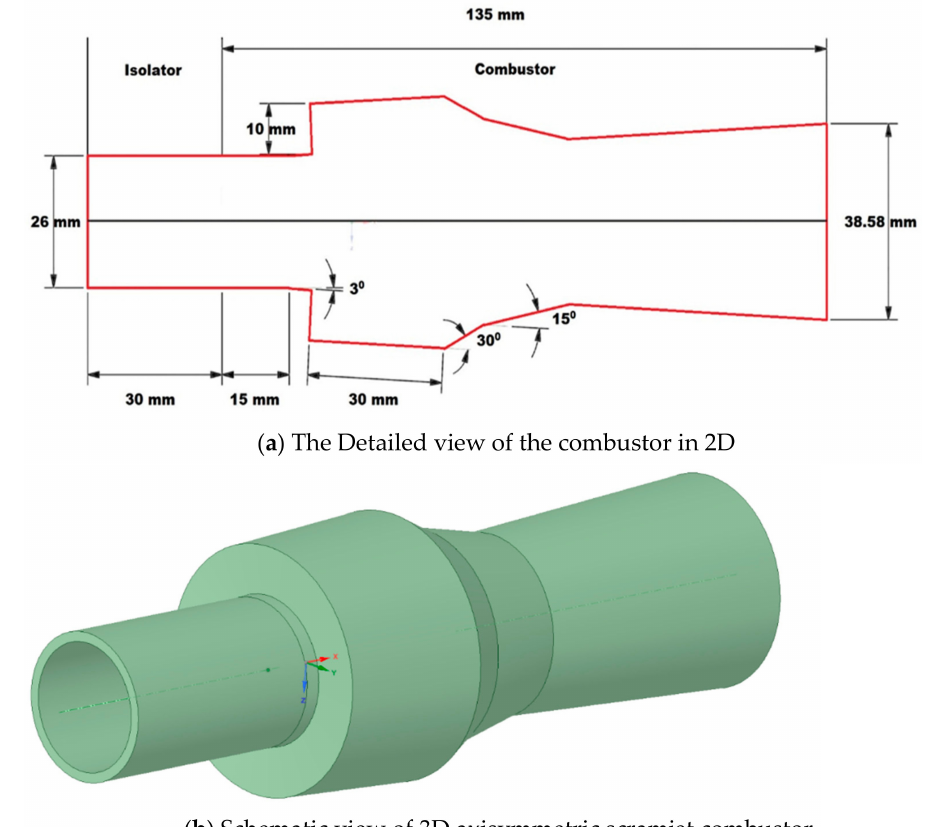
Figure 1. The computational domain of the scramjet